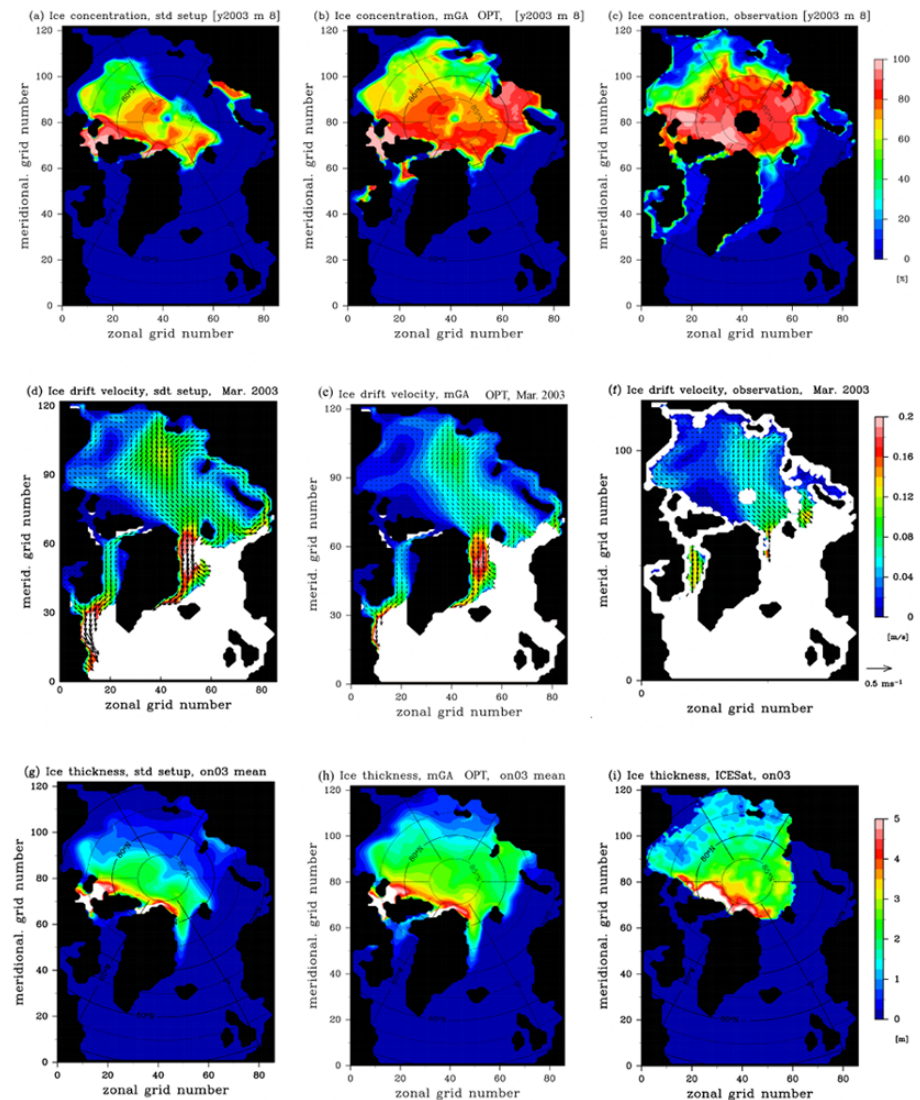
Fig. 13. The same as Fig. 8 but with the average of the µGA – 1. The results from the standard setup (the left column) and from satellite observations (the right column) are again shown to facilitate